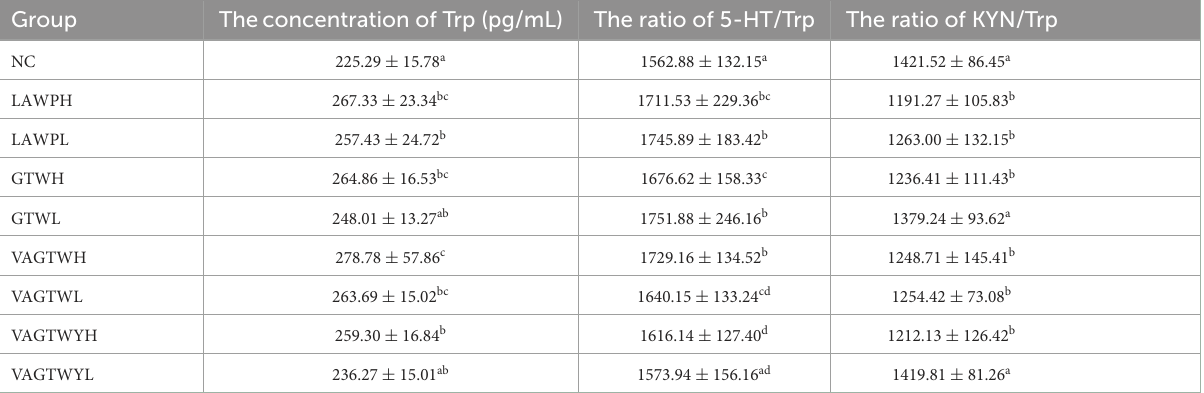
TABLE 3 The effect of Trp peptides on Trp